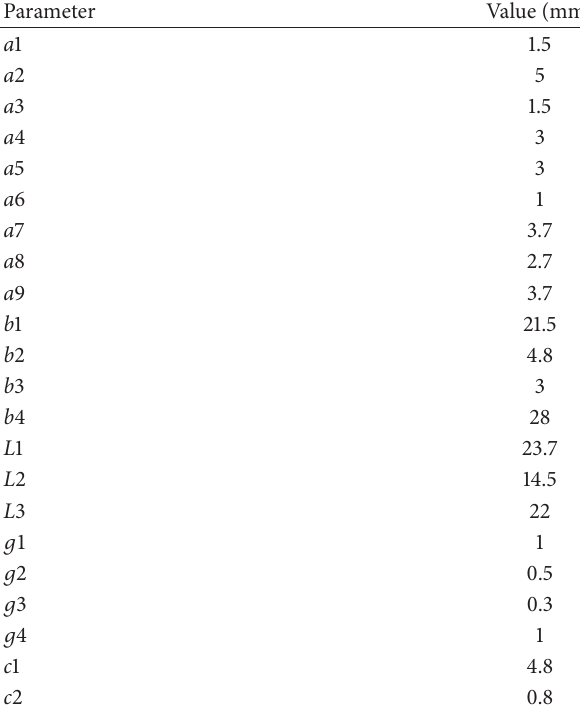
Table 2: The parameters of the proposed antenna.